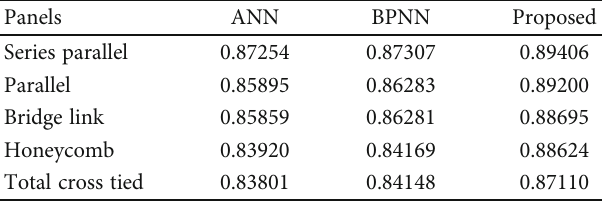
Table 2: Precision.